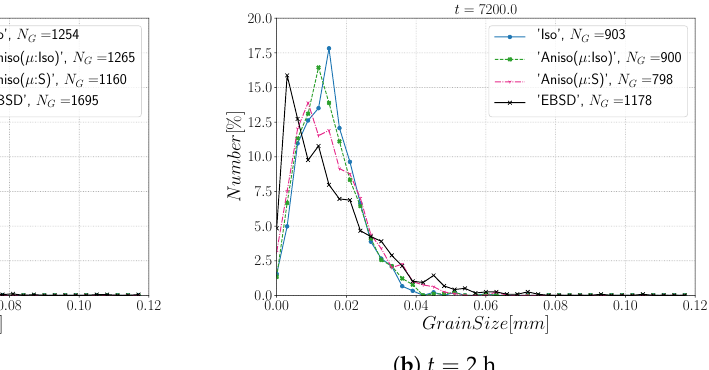
Figure 23. Grain size distributions obtained at ( a ) t = 1 h and ( b ) t = 2 h for the isotropic (Iso) formulation, anisotropic formulations with isotropic GB mobility (Aniso( µ :Iso)) and heterogeneous GB mobility (Aniso( µ :S)), and the experimental data (EBSD); N G refers to the number. Numerical results obtained from the initial immersed microstructure shown in Figure 18 and the RS and Sigmoidal model to define GB energy and